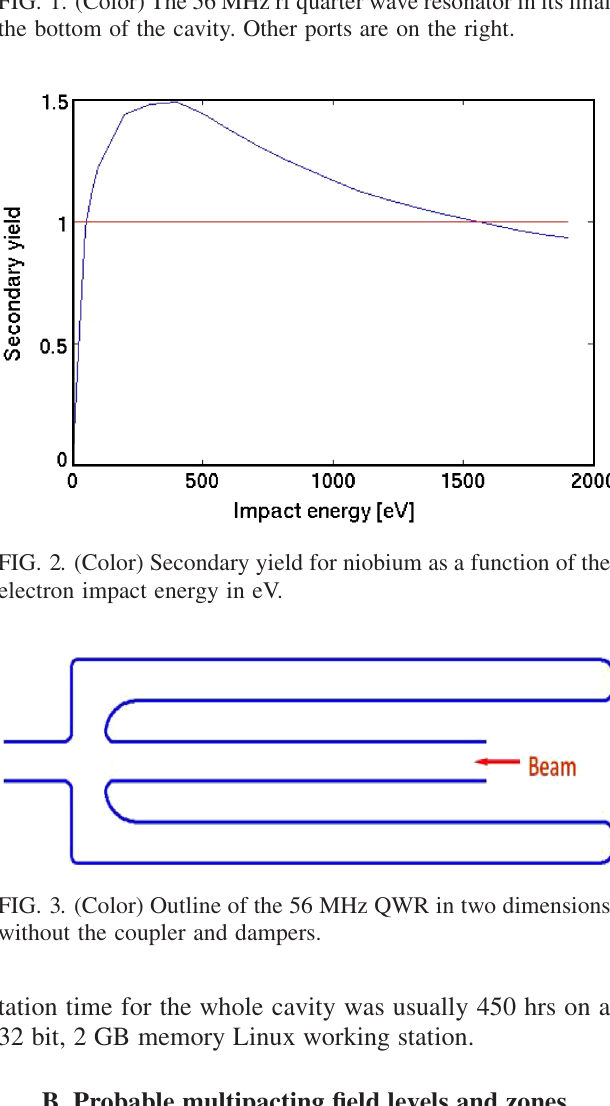
field.FIG. 1. (Color) The 56 MHz rf quarter wave resonator in its final shape. Dimensions are given in inches. The fundamental damper is at